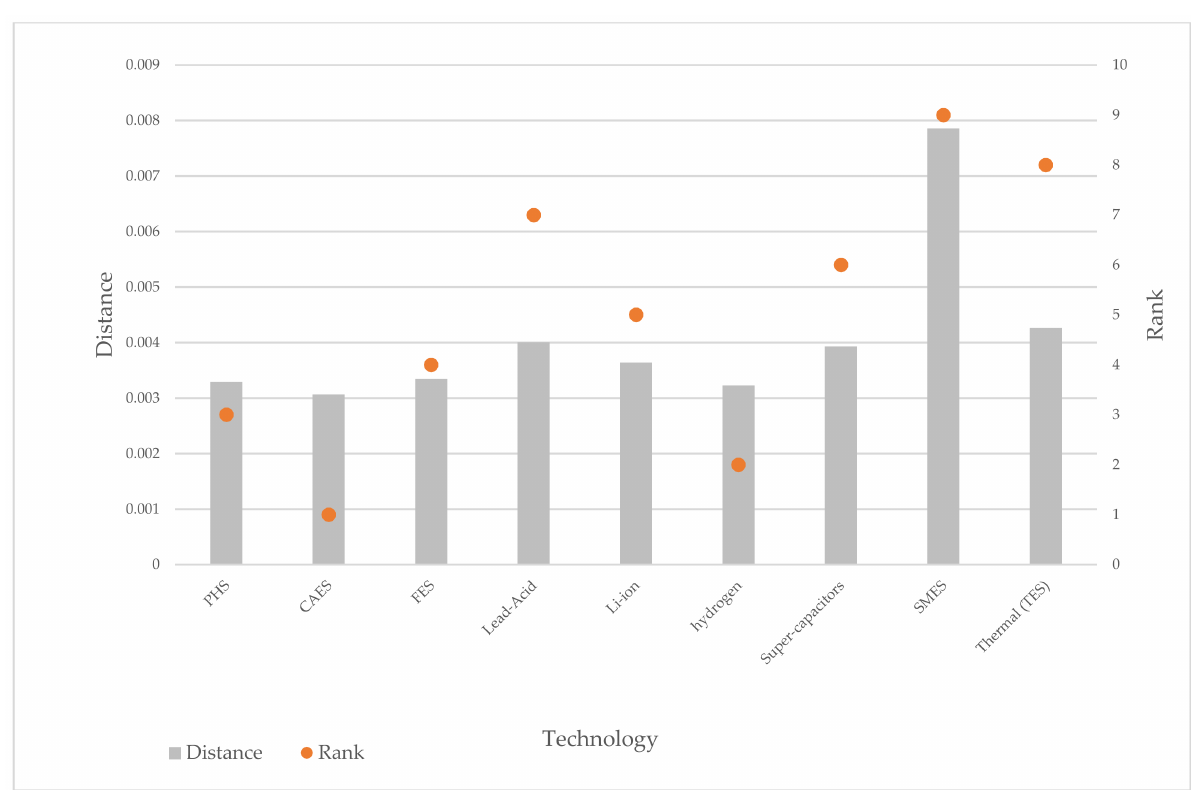
Figure 7. The distance calculation and ranking results in Scenario